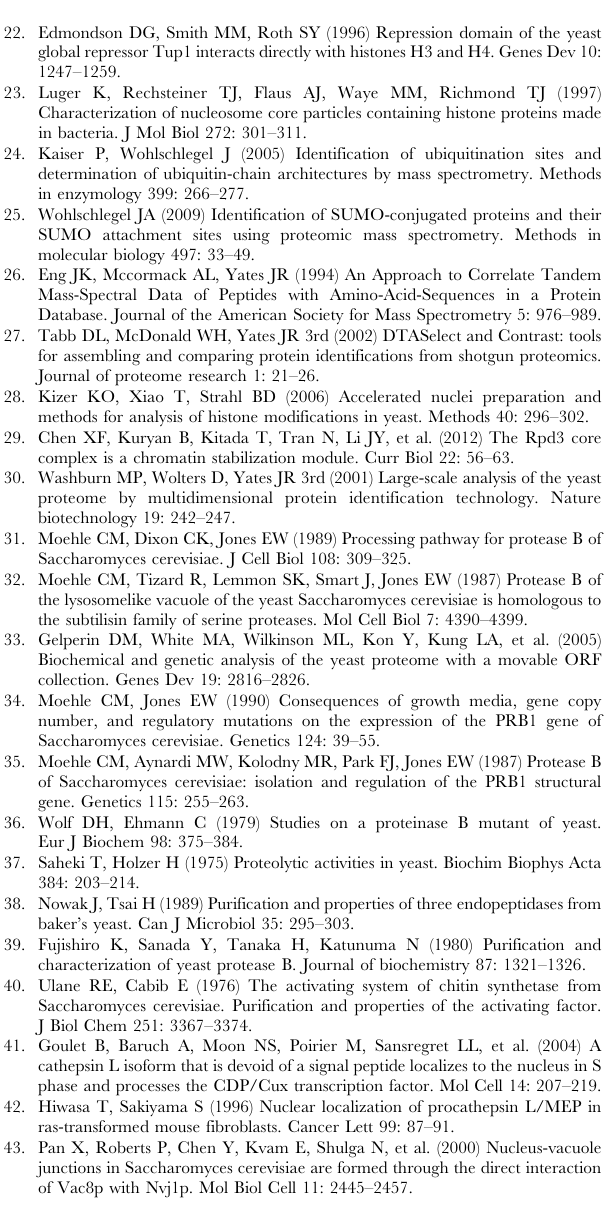
Table S1 List of yeast strains and plasmids. Table S2 List of proteins identified by Mass Spectrom- etry in the HIC